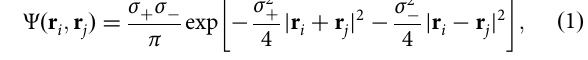
tary Fig. S1 in Supplementary Note 1: Localized modes examples, resulting from numerical simulation).